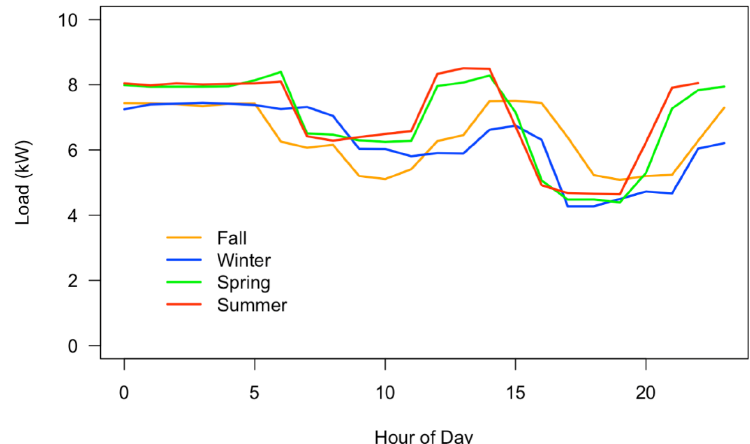
Figure 1. Averaged hourly electric daily load profiles of a container farm in Whitehorse, Yukon for fall (September–November), winter (December–February), spring (March–May), and summer (June–August). Electricity use is greatest overnight along with a midday peak when all loads (lighting, heating / cooling / ventilation, dehumidification) are operating. Reductions in electric use occur in the mid-morning hours, which can be attributed to reduced heating, cooling, and dehumidification as well as late afternoon and evening hours when lighting is turned o ff . Summer electricity use is generally highest, given substantial cooling required to exhaust waste heat from operating electric loads, which are nearly su ffi cient to heat the opaque container in the